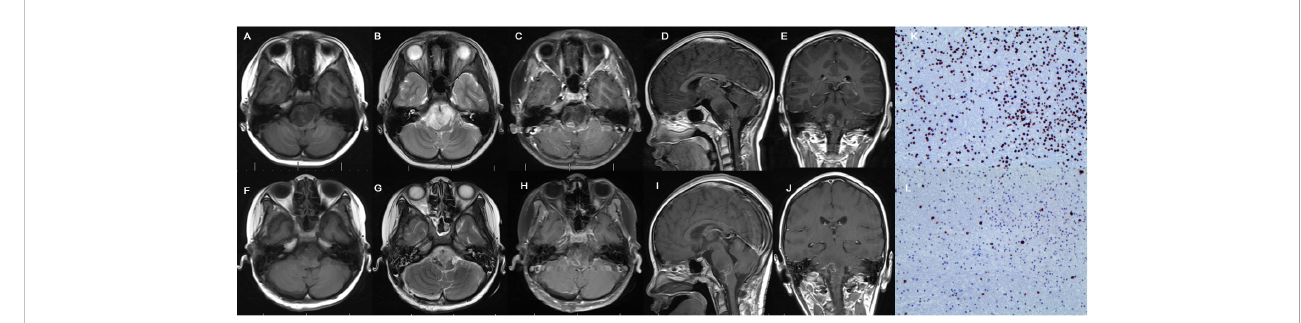
FIGURE 3 Cranial MRI examination revealed glioma located in the brainstem with extrapontine lesion, showing mixed hypointense and hyperintense in T1 (A) and hyperintense signal in T2 (B) and irregular enhancement (C – E) in preoperative images. Postoperative MRI con fi rmed partial resection (F – J) . Immunohistochemistry indicates H3K27M positive (K) and Ki-67 positive (L)